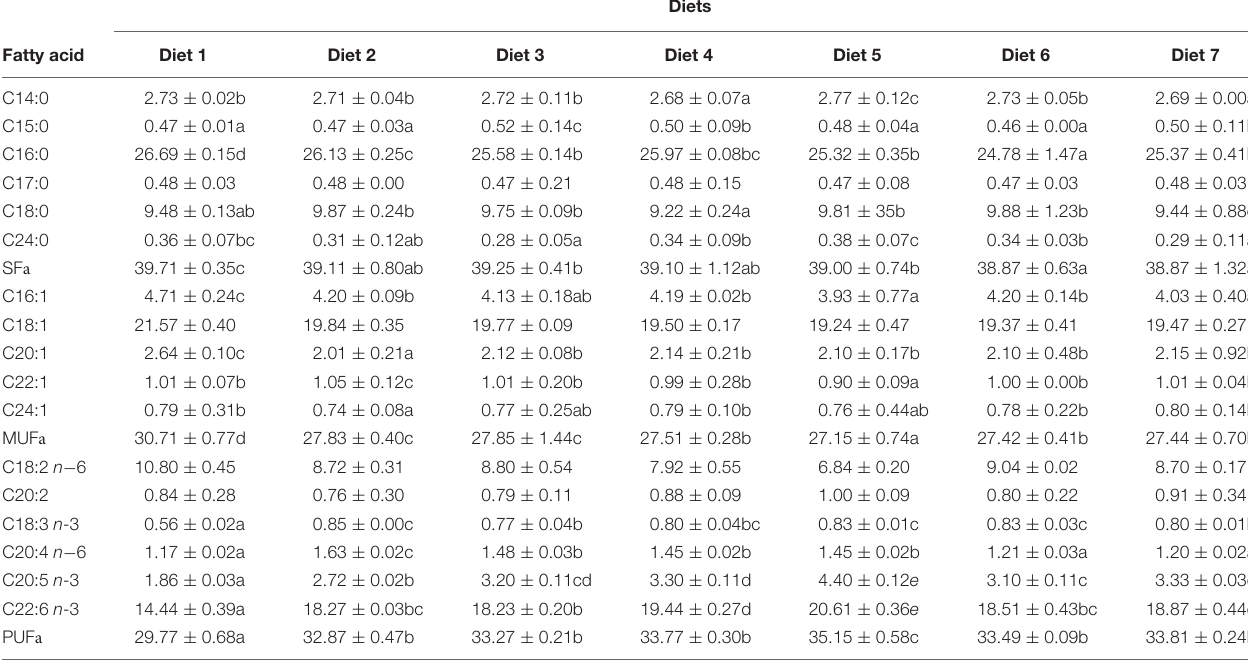
TABLE 5 | The percentage content of fatty acids in liver of Trachinotus